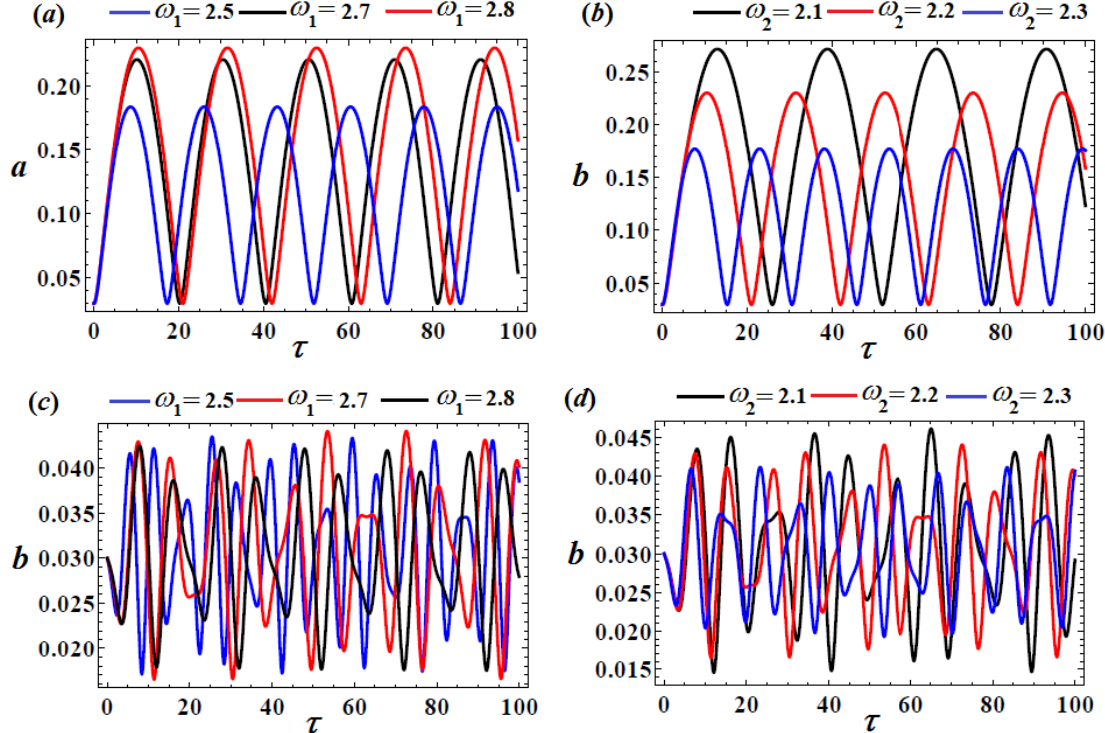
Figure 6. Behavior of the amplitudes a and b with regard to the horizontal elongation ξ and the rotation angle θ respectively: ( a , c ) at ω 1 (= 2.5,2.7,2.8 ) s − 1 and ( b , d ) at ω 2 (= 2.1,2.2,2.3 ) s − 1 .